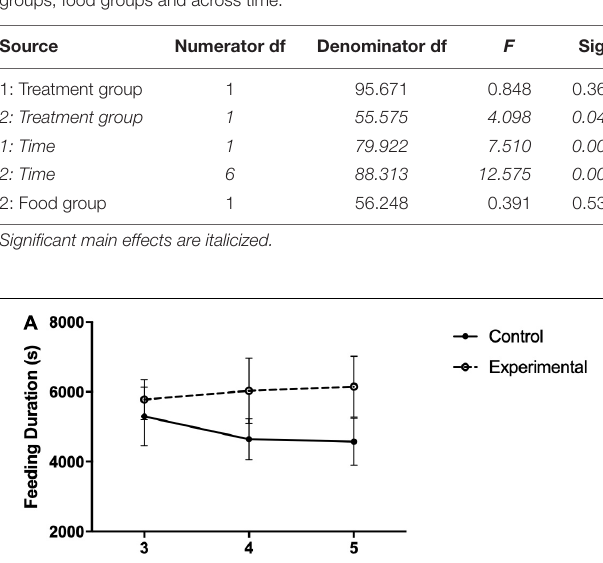
TABLE 6 | Fixed effects from the linear mixed effects model of time spent at the food cup in study 1 (indicated by 1) and study 2 (2) between treatment groups, food groups and across time.